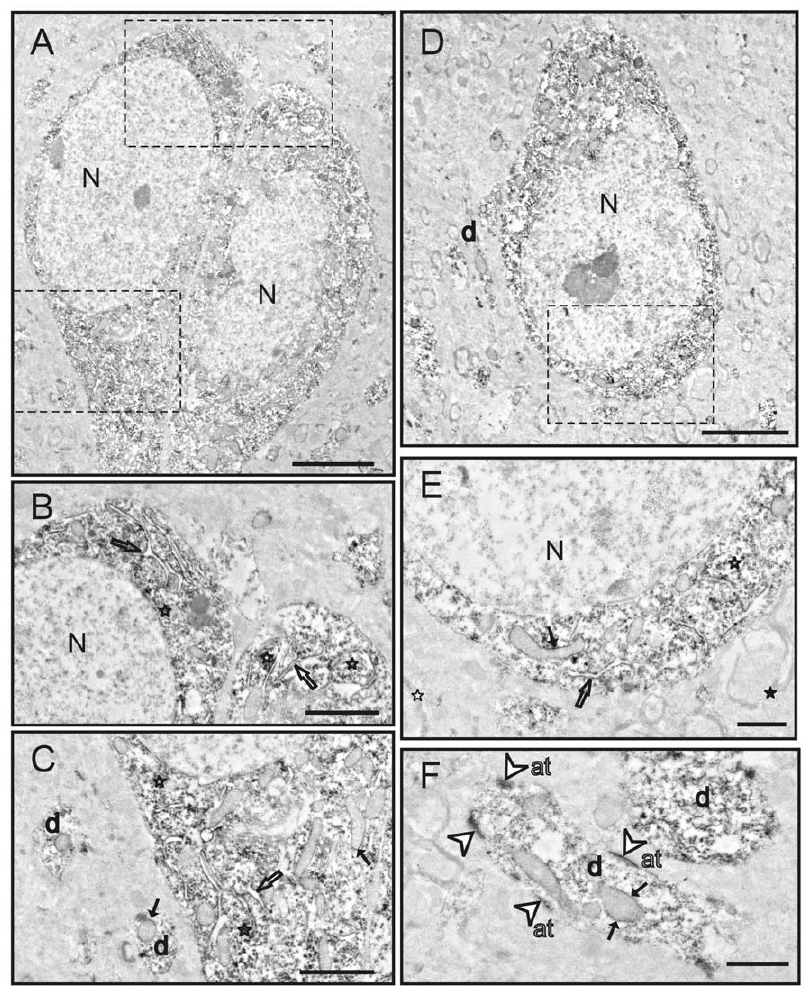
Figure 4. Electron microscopy images of GSK3 b labeling in the piriform cortex. A) Two adjacent labeled neurons. B) Detail of neurons in A . GSK3 b labeling is located in the rough endoplasmic reticulum (outlined arrows) and free ribosomes (outlined stars). C) Detail of neurons in A showing labeled mitochondria (black arrows), abundant labeled free ribosomes (outlined stars), and also labeled rough endoplasmic reticulum (outlined arrows). Note also the labeling in dendrites (d). D) Another labeled neuron with strong cytoplasmic staining. Dendrites (d) are also labeled. E) Detail of neuron in D showing strongly labeled rough endoplasmic reticulum (outlined arrow), free ribosomes (outlined stars) and also labeling on the outer surface of the mitochondria (black arrows). Note also unlabeled myelinated axons (black star). F) High magnification image of two dendrites (d). GSK3 b staining is conspicuously present on the postsynaptic density (outlined arrowheads). Cytoplasmic elements including the outer membrane of mitochondria (black arrows) are also labeled. However, no labeling is present in axon terminals (at). [N: nucleus; Scale bars: 4 m m in A–D; 1 m m in B–C and E–F]